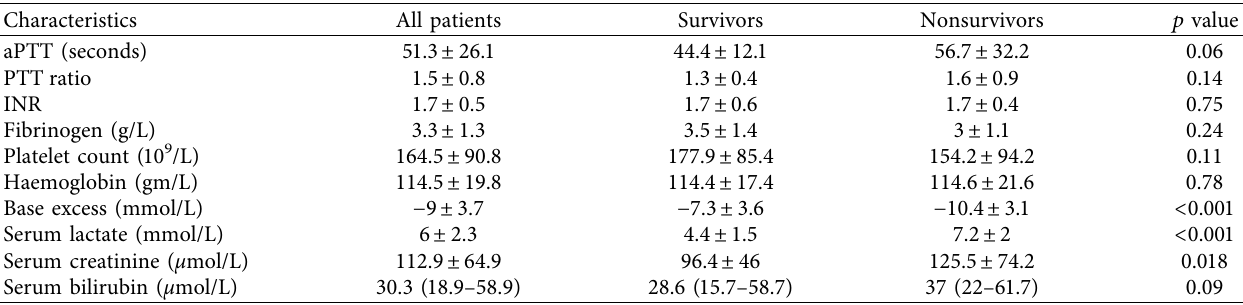
Table 3: Laboratory data at ECMO